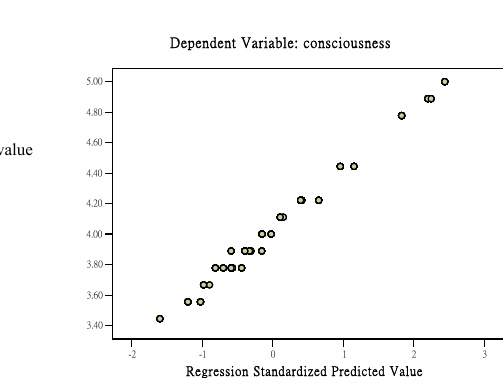
Figure 7: The scatter plot for the fuzzy semantics of consumer’s perceived value predicted by the product design features through the linear regression analysis Independent samples